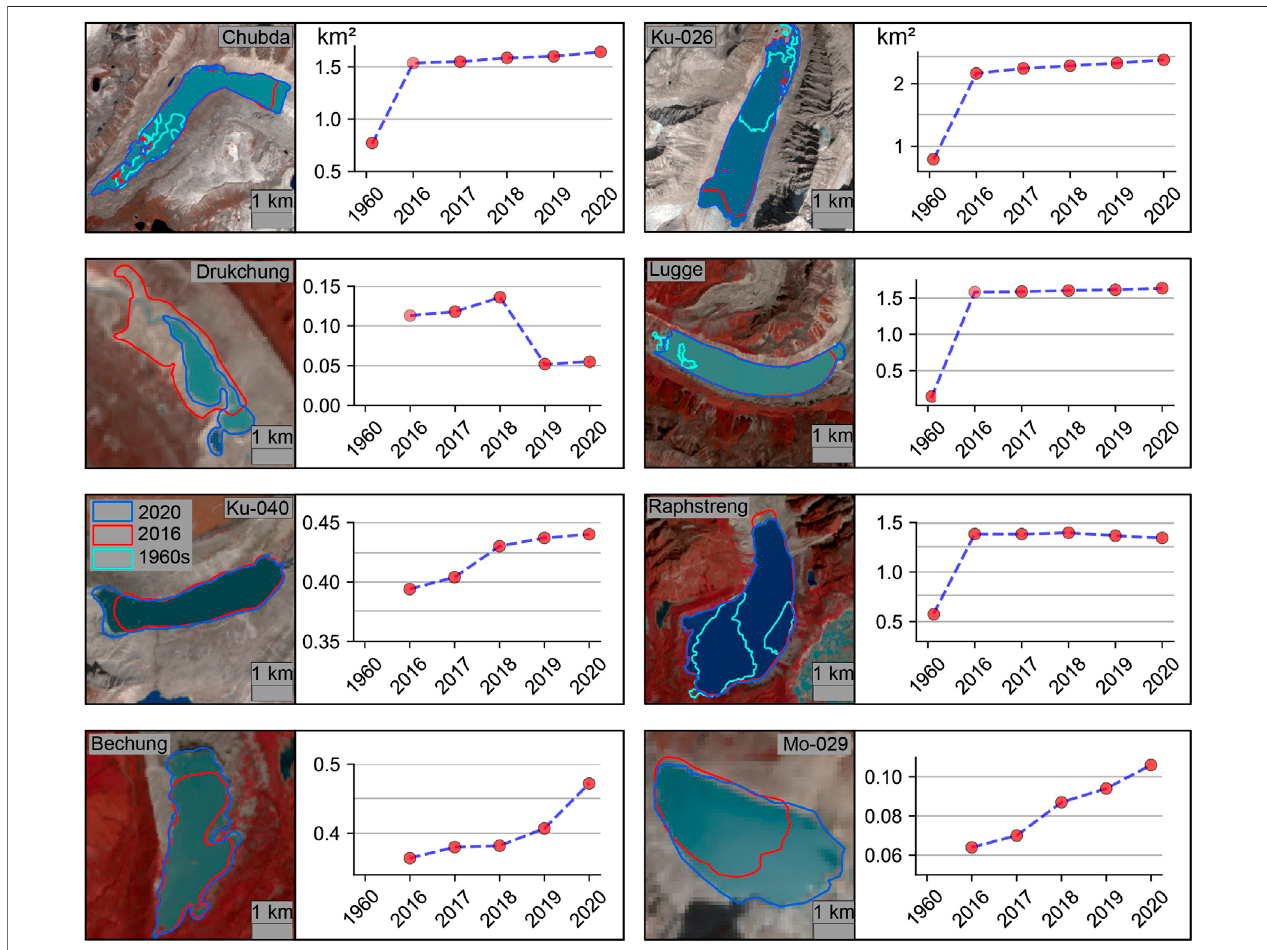
FIGURE10| Examplesoflakesthathaveexhibitedtypicalexpansionsincethe1960sandwhichhaveundergoneadistinctannualchange.ChubdaTsho,Ku-026, LuggeTsho,andRaphstrengTshoaredistinctiveexamplesoflakesinthesupraglaciallakestageinthe1960swhichexpandedrapidlyaftermergingtoasingleproglacial lake. Drukchung Tsho and Raphstreng Tsho have recessed between 2016 and 2020.